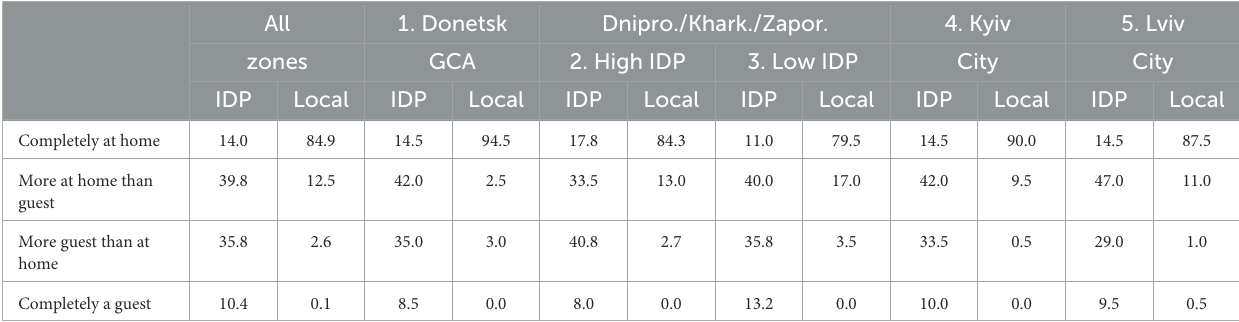
TABLE 9 Sense of being at home (column %).